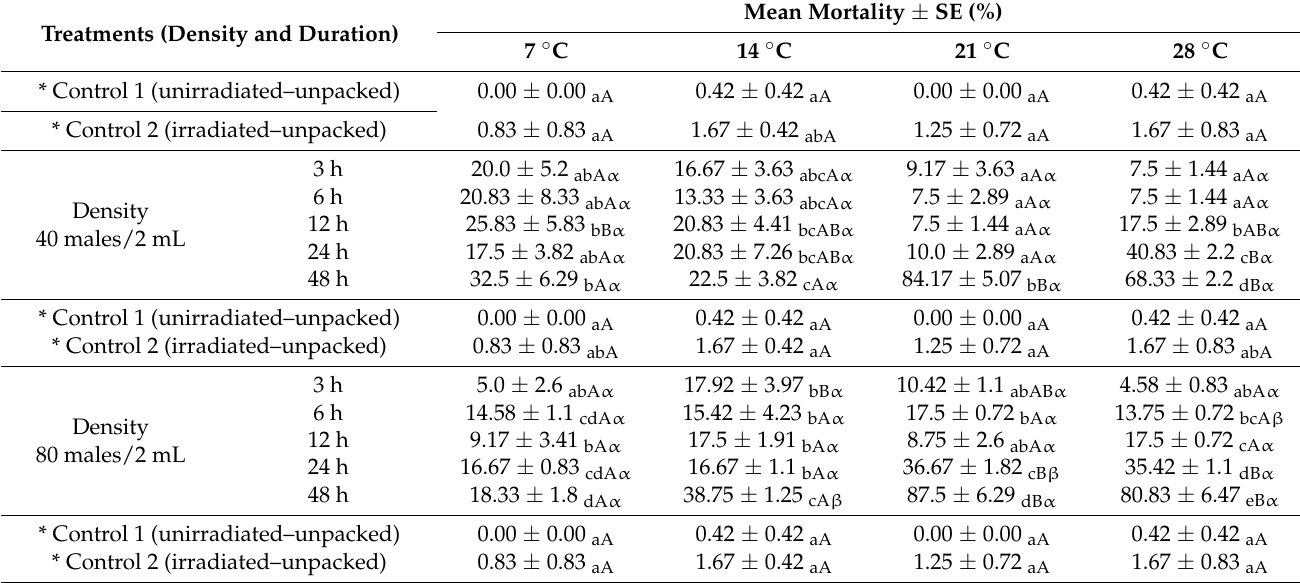
Table 2. Mean mortality of gamma-sterilized male Ae. aegypti post-treatment by density, temperature, and duration